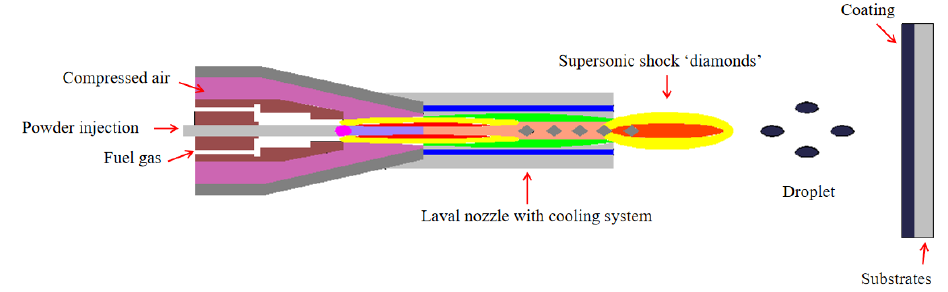
Figure 1. Schematic presentation of HVAF/HOVF spraying technology.